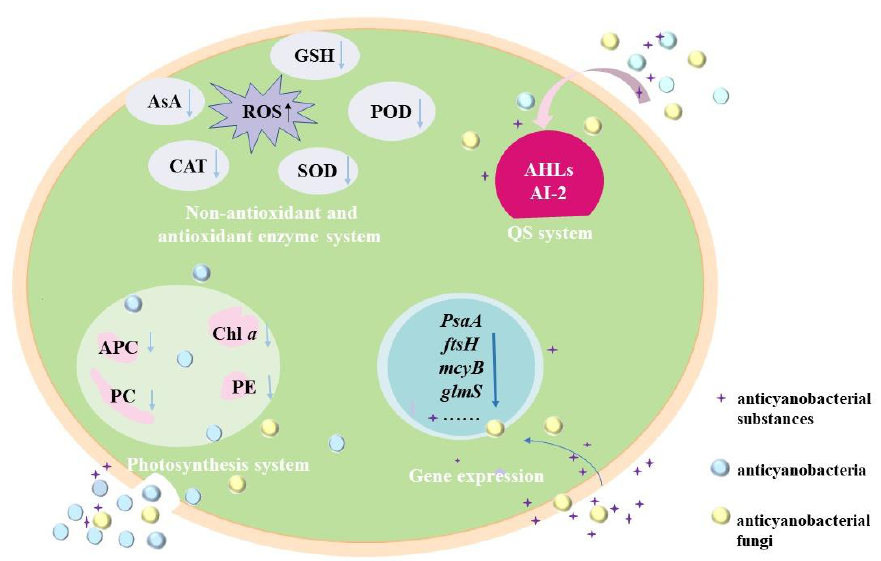
Figure 2. Anticyanobacterial mechanisms of microorganisms against M. aeruginosa.